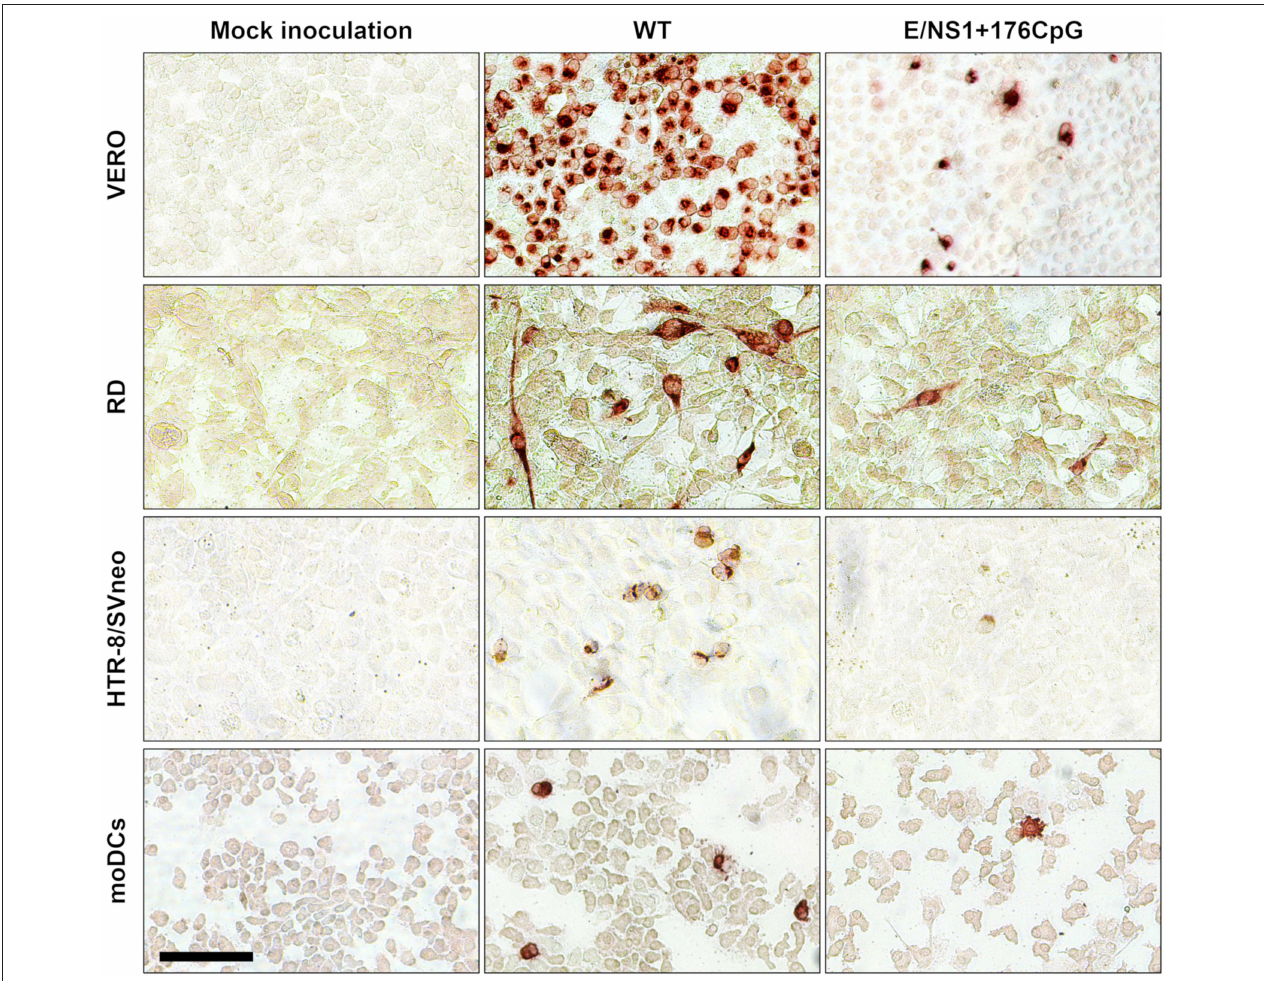
FIGURE 4 | Representative ZIKV antigen staining in cell lines and human moDCs. Brown staining represents ZIKV-positive cells. The bar is 100 µ